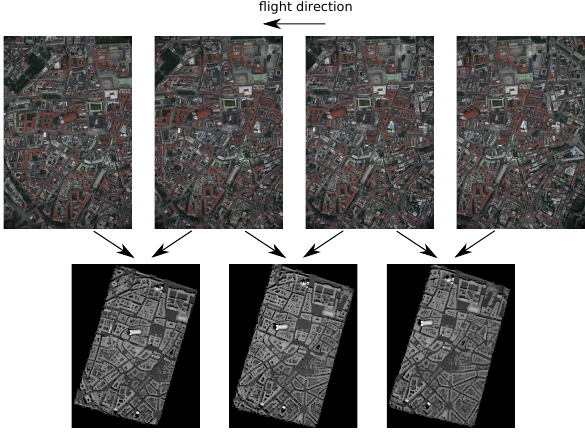
Figure 1. Pairwise dense matching and DSM generation.